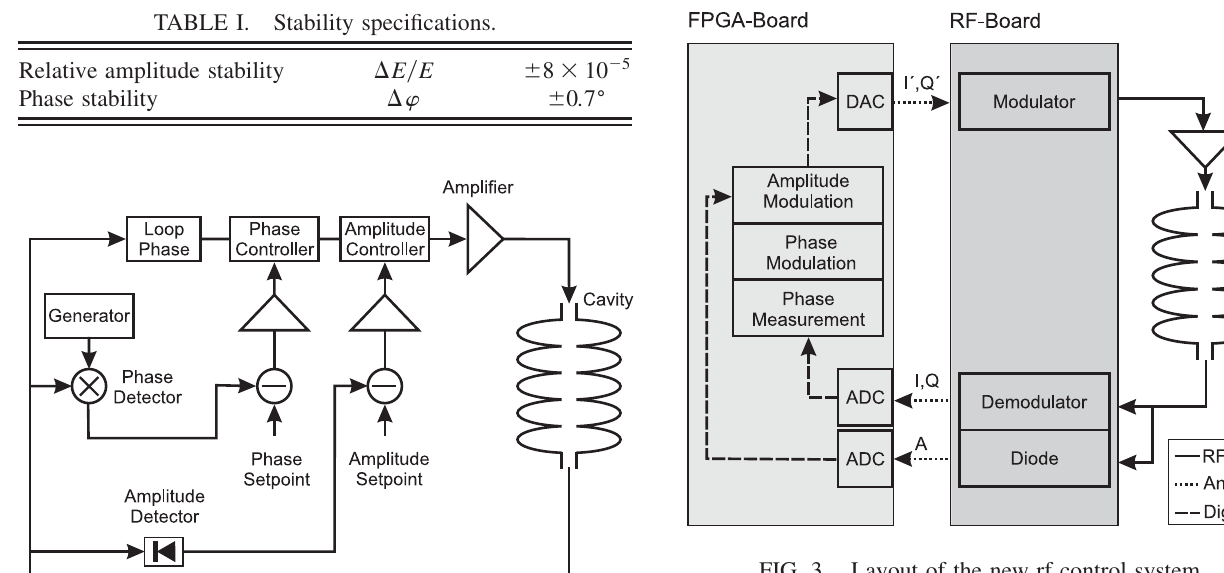
FIG. 3. Layout of the new rf control system.